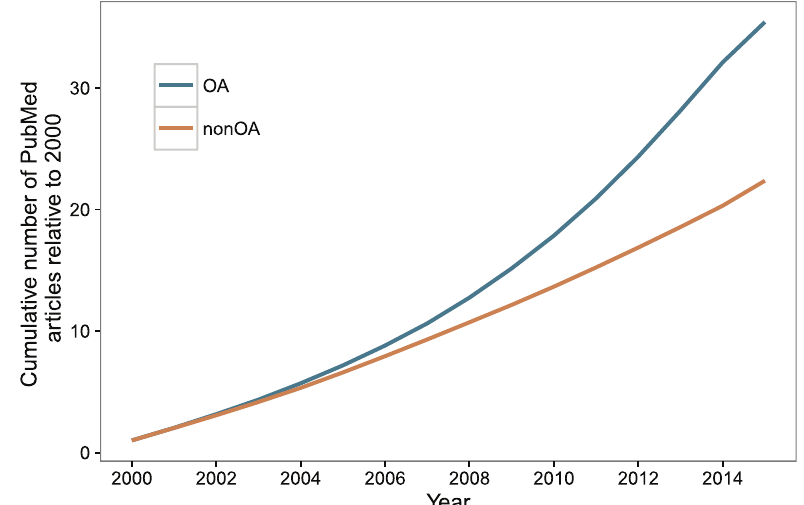
Figure 1. Percentage increase in research articles in PubMed Central, relative to 2000. Since 2004, the growth rate of OA articles is significantly higher than that of non-OA